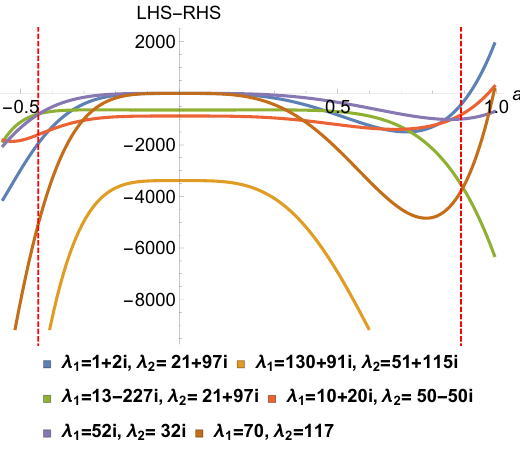
Figure 8: Red lines are the a = − 4 / 9,8 /